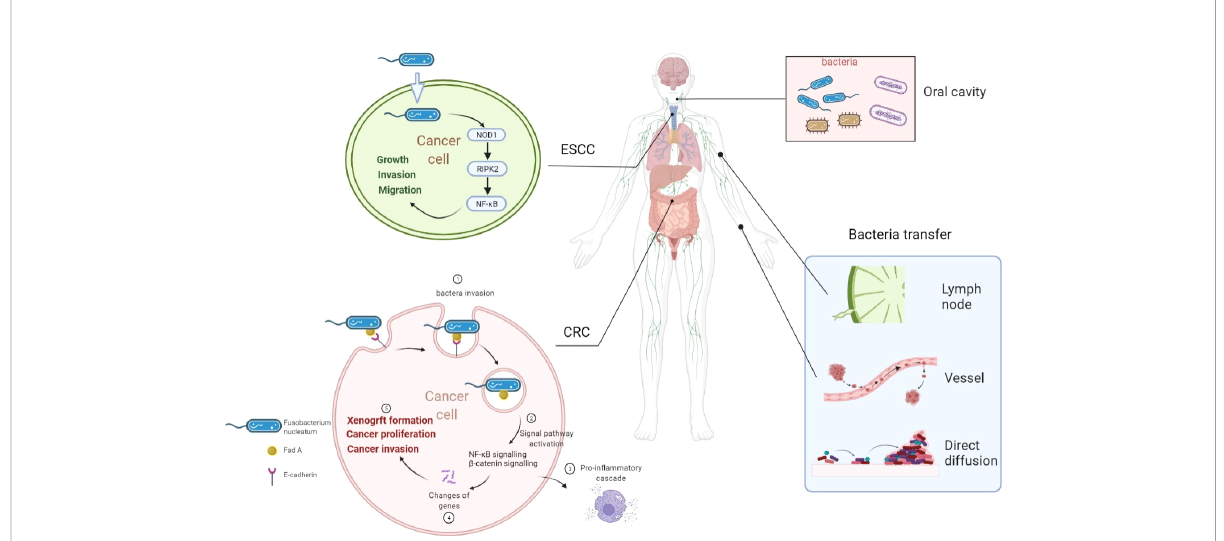
FIGURE 1 Overview of proposed mechanisms that Fusobacterium nucleatum invading cancer cells. F. nucleatum is a common bacterium in the oral cavity. F. nucleatum invades ESCC cells and CRC cells. F. nucleatum may transfer through lymph, vessel, or direct diffusion. F. nucleatum promotes ESCC progression by the NOD1/RIPK2/NF k B pathway. FadA is highly conserved among F. nucleatum and expressed on the bacterial surface. FadA binds E-cadherin on CRC cells to attach and invade CRC cells. Then, NF k B signaling and b -catenin signaling are activated to induce a pro-in fl ammatory cascade to promote CRC progression. ESCC, esophageal squamous cell carcinoma; CRC, colorectal cancer; Fn , Fusobacterium nucleatum ; NOD1, nucleotide-binding oligomerization domain-containing protein 1; RIPK2, interacting serine threonine kinase 2; NF k B, nuclear factor- k